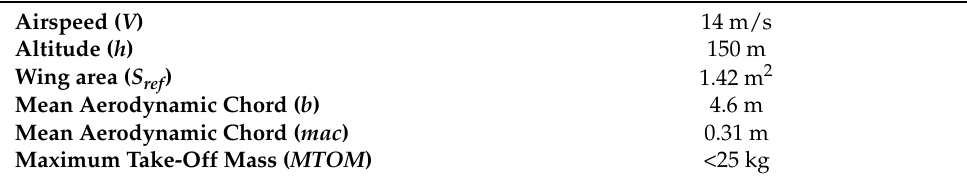
Table 1. Reference data of the test aircraft and flight conditions.